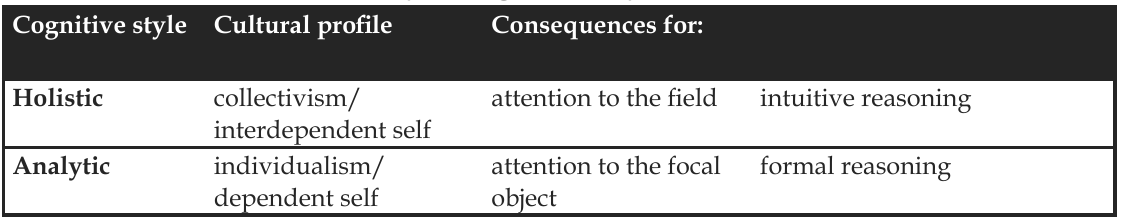
Table 3: Holistic and analytic cognitive